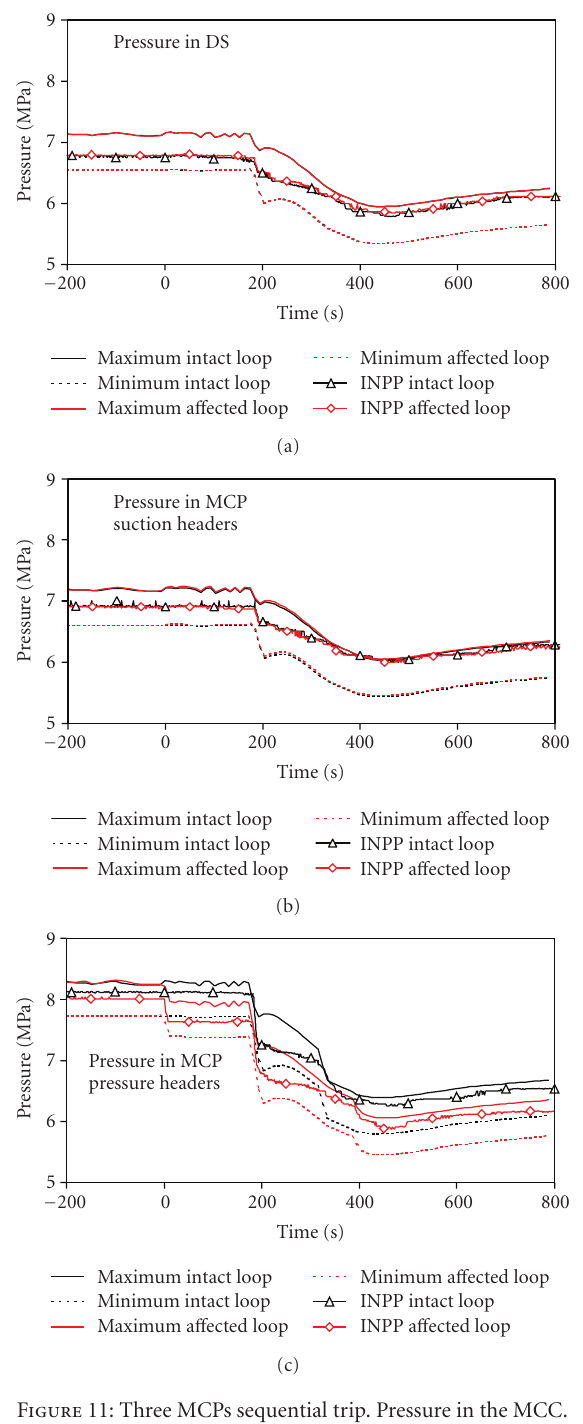
Figure 11: Three MCPs sequential trip. Pressure in the MCC.